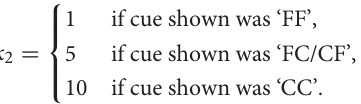
Frontiers in Neuroscience |